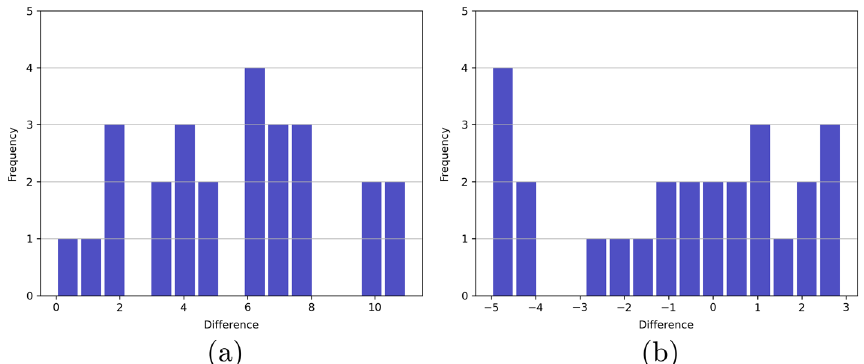
Fig. 5 Differences of shortest path distances between approximated central nodes obtained using the YTQ and our pruning methods with respect to the exact most central node on two random graphs: (5a) : the first (diameter of 26, 125 nodes and 180 edges) and (5b) : second (diameter of 36, 289 nodes and 597 edges) random graphs. Positive values indicate that our method is better than the YTQ